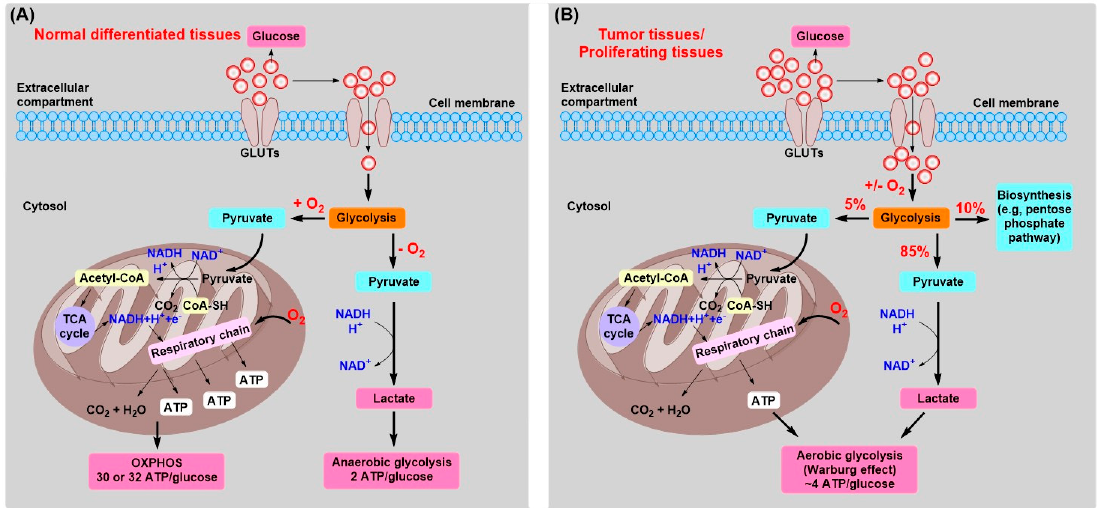
Figure 1. The energy metabolism of normal differentiated tissues and tumor or proliferating tissues. ( A ) In normal differentiated tissues, under aerobic condition, a molecule of glucose is first converted to two pyruvates via glycolysis in the cytosol, followed by undergoing TCA cycle to produce CO 2 in the mitochondria. A total of 30 or 32 ATP molecules are generated during this process. Under anaerobic condition, glycolysis is preferential and less pyruvate is shifted to the oxygen-consuming mitochondria, only 2 ATP molecules are produced per molecule of glucose. ( B ) In tumor or proliferating tissues, mitochondrial function is still normal, but little mitochondrial oxidative phosphorylation (OXPHOS) continues in tumor cells. In order to satisfy the metabolic requirements of both energy and materials for rapidly proliferating cells, ~85% of the glucose is processed to lactate via glycolytic pyruvate even in the presence of oxygen and ~5% of the glucose is metabolized by OXPHOS. In addition, ~10% of the glucose is diverted into the upstream of pyruvate production for biosynthesis (e.g., pentose phosphate pathway, PPP).